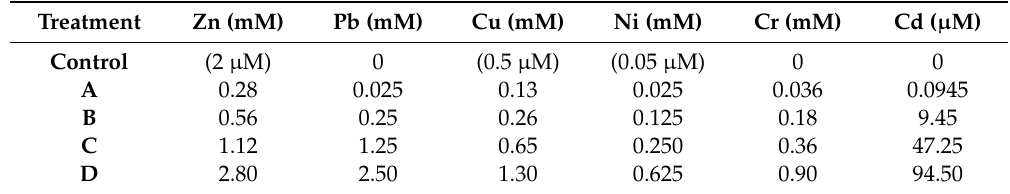
Metal concentration of the nutrient solutions for each tested element.